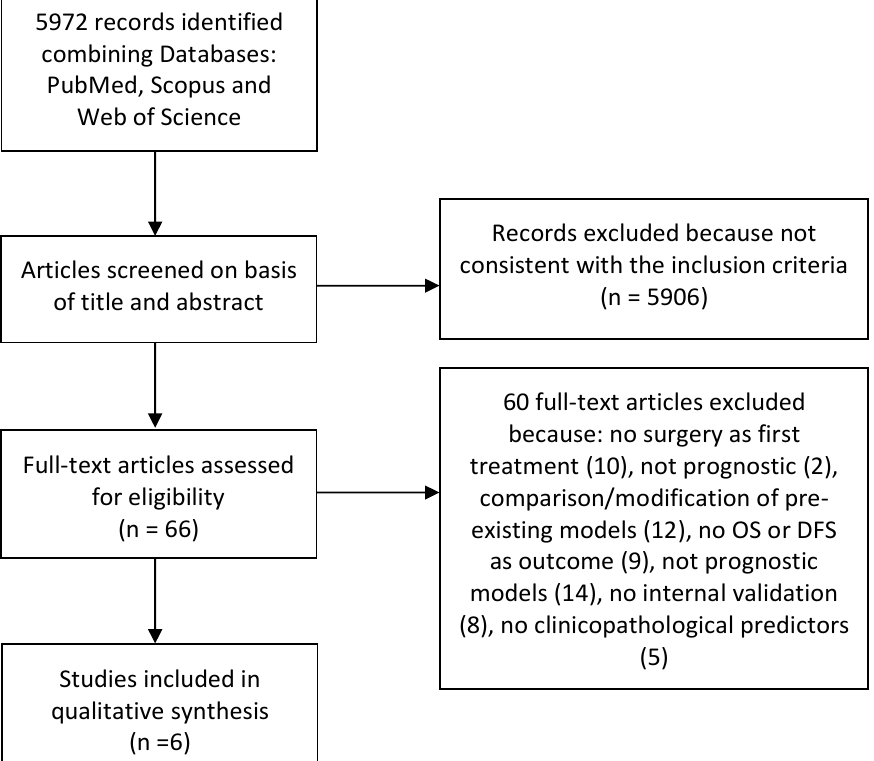
Figure 1. Flow-chart: 5972 records were identified in the initial search and, among them, 66 were further evaluated by reading the full text. At the end of the selection process, 6 articles were considered suitable for inclusion in this systematic review.